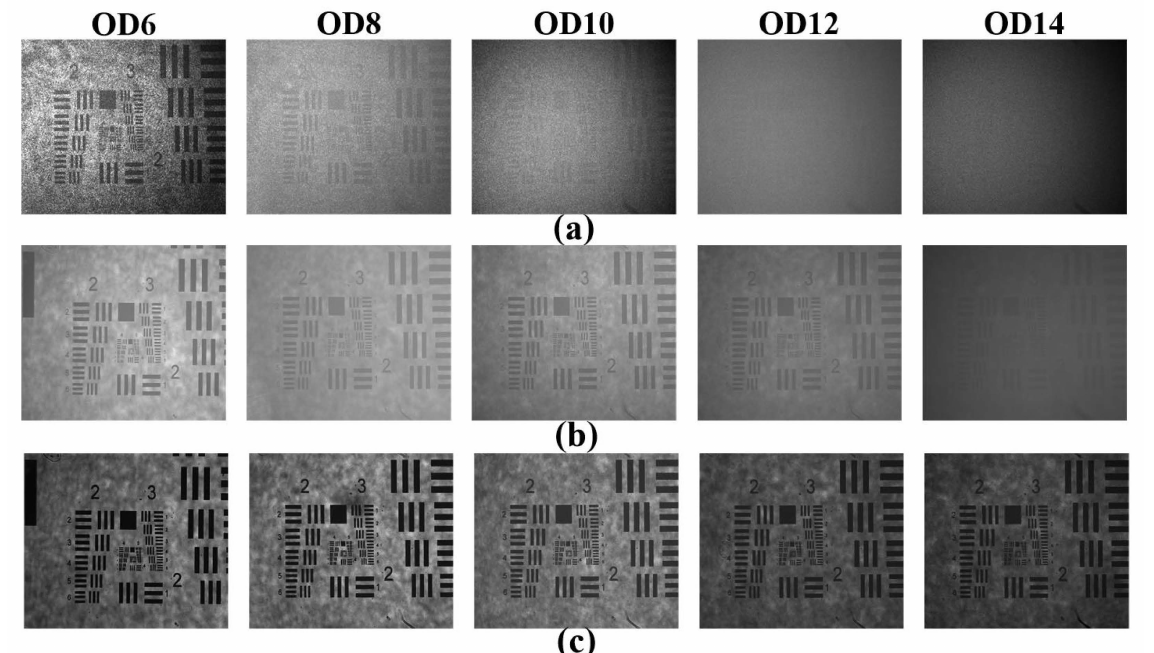
Figure 2. Images of the test patterns hidden behind the turbid medium by using different light illumina- tions under different OD conditions: ( a ) femtosecond laser illumination; ( b ) SC illumination of without spatial filtering; and ( c ) combination of supercontinuum illumination and Fourier spatial